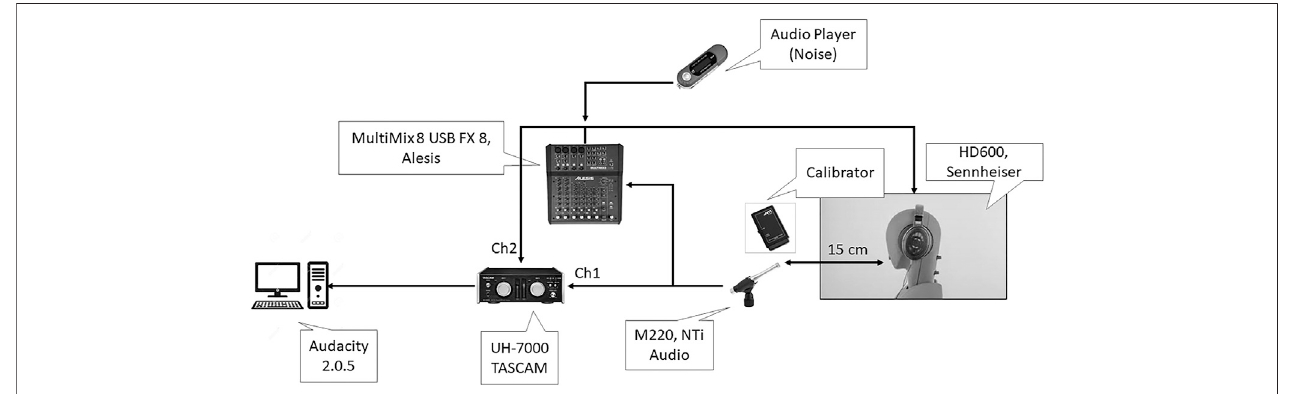
FIGURE 1 | Equipment set-up for experimental